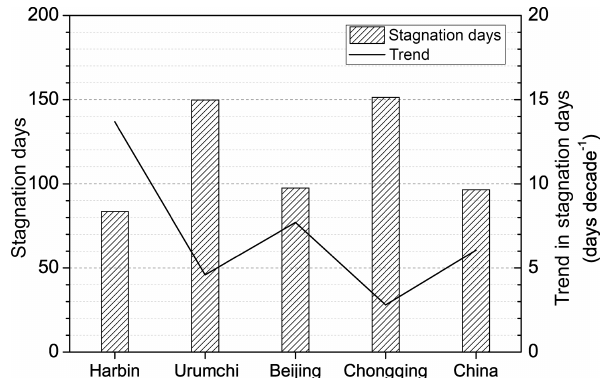
Figure 6. Annual mean stagnant days and the corresponding trends at four stations (Harbin, Urumchi, Beijing, and Chongqing) and for the whole